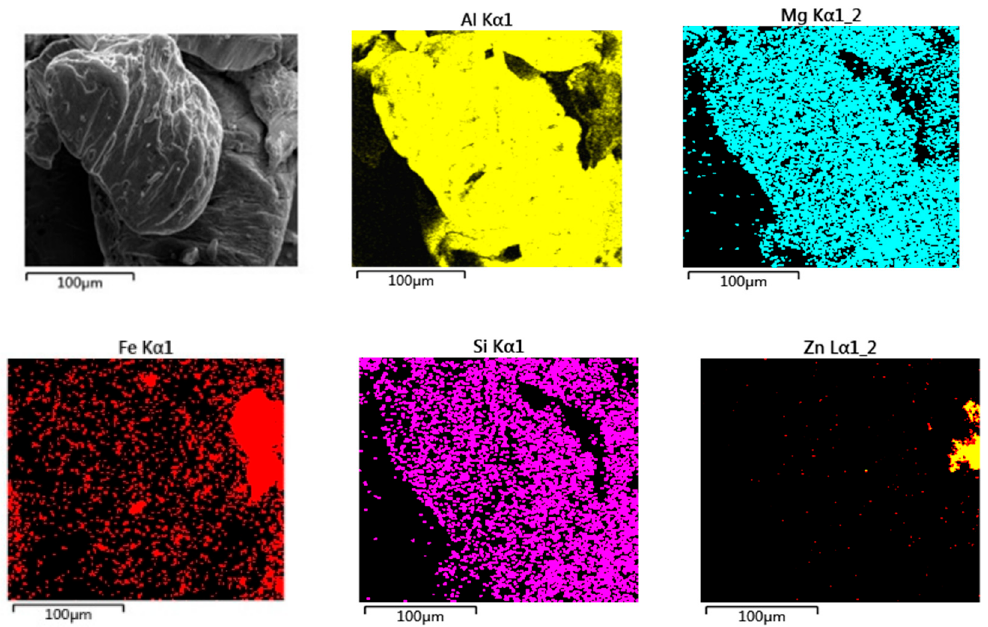
Figure 11. Energy-dispersive spectrometer (EDS) analysis of fatigue fracture on stirring zone (STZ) of dissimilar Al/steel keyhole-free FSSW joints.